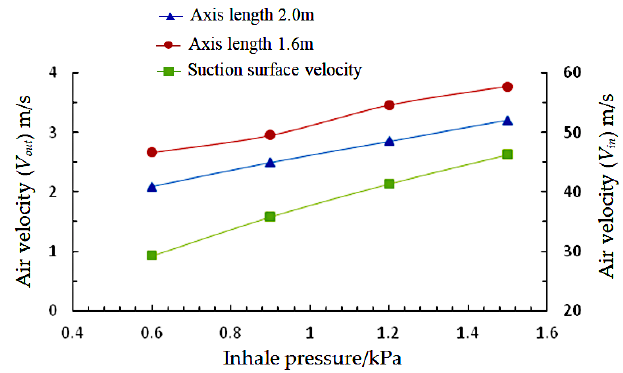
Figure 29. Liquid film thickness clouds for an ultra-large ellipsoidal recovery hood.